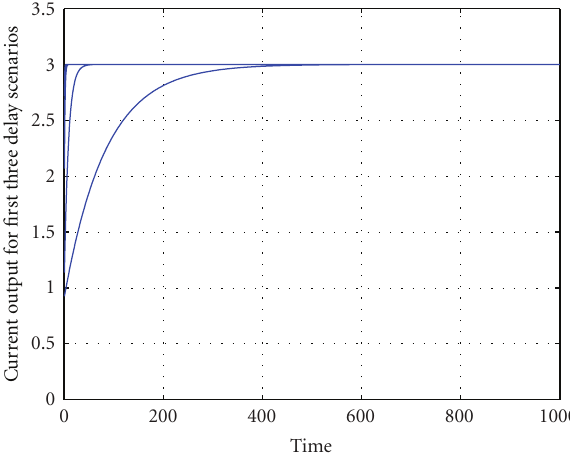
Figure 5: Systems response to those di ff erent time delay